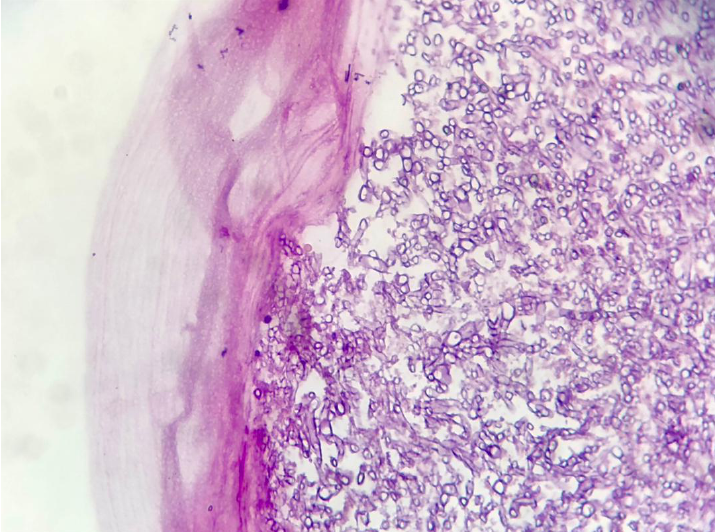
Figure 3. Lamellar membrane of hydatid cyst and adjacent fungal hyphae aggregation, morphologically consistent with aspergillosis, H&E,